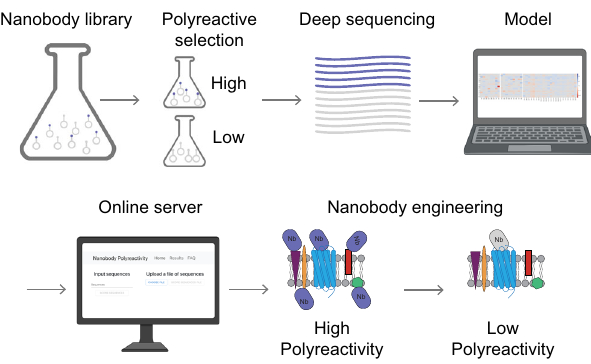
Fig. 1 | Development of a computational tool to assess and mitigate poly- reactivity. Starting from a large, naïve synthetic nanobody library, pools of nanobodies with low and high polyreactivity were isolated. Machine learning models were trained on deep sequencing data from these pools to learn sequence features of low and high polyreactive nanobodies. These algorithms were incor- porated into software that quantitatively predicts polyreactivity levels and recommends substitutions that reduce it. Created with